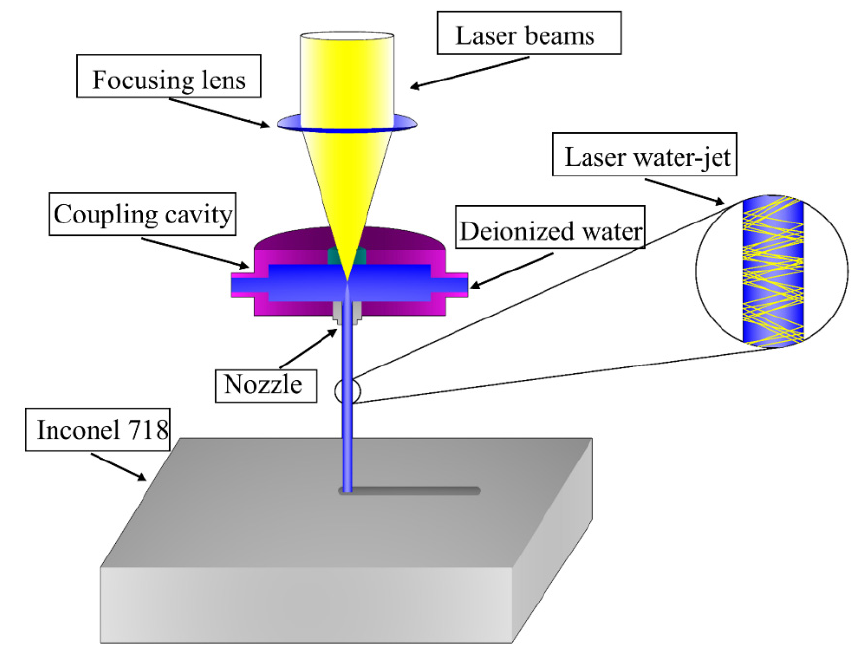
Figure 4. Principle of the water-jet-guided laser processing.